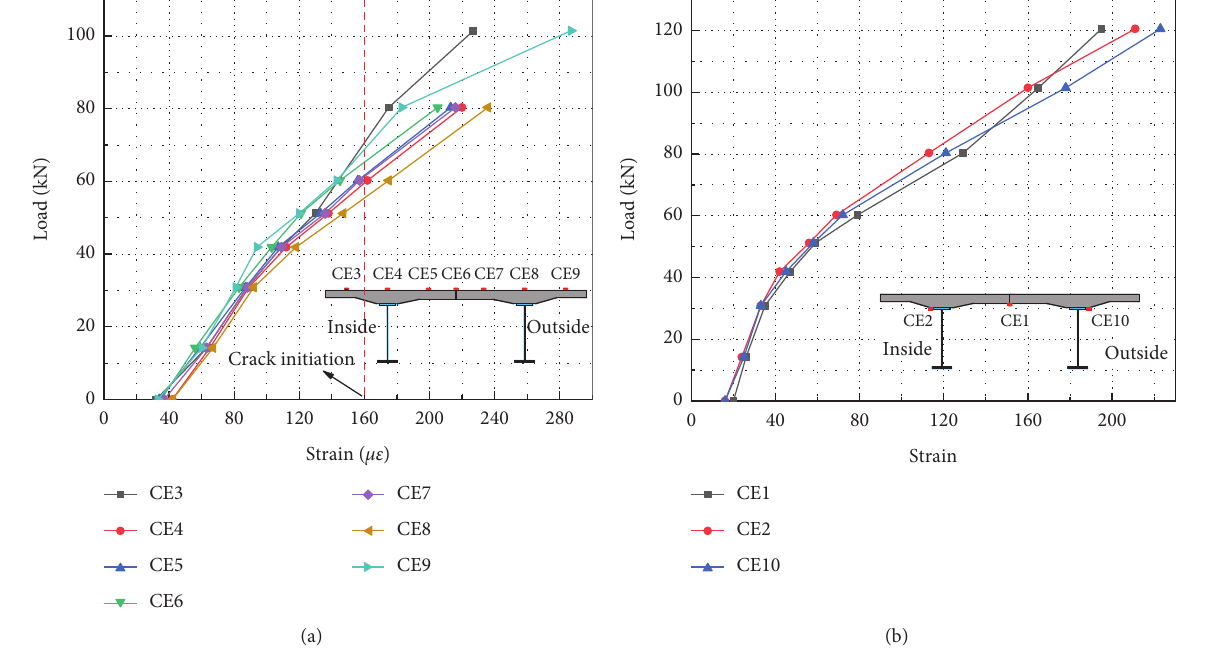
Figure 11: Load-strain relationship on the concrete slab at the intermediate support section (section E ). (a) Top surface of the concrete slab. (b) Bottom surface of the concrete